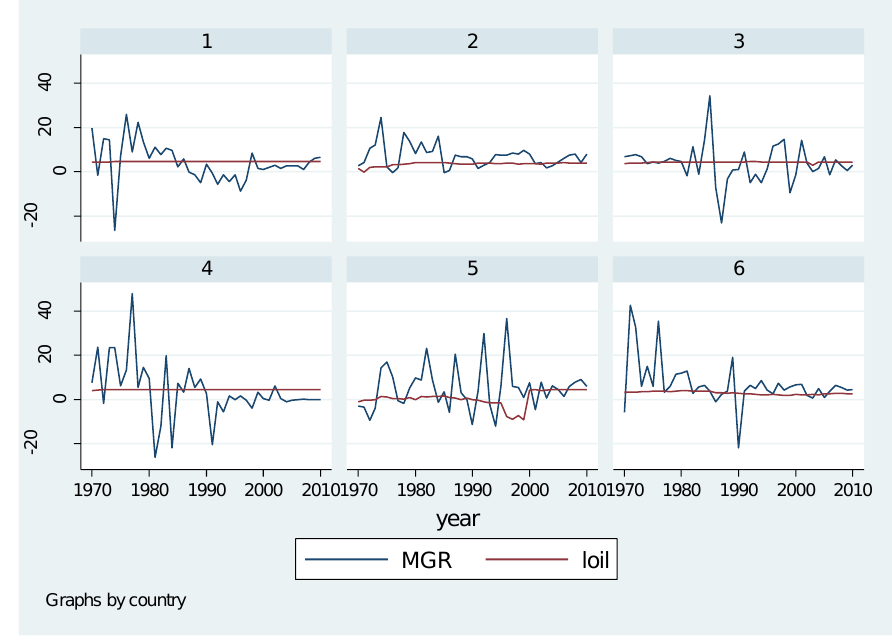
FIGURE 1: Manufacturing sector growth rate (mgr) and oil revenue (oil ) in AOECs Source: Authors’ calculations 1 = Algeria; 2 = Egypt; 3 = Gabon; 4 = Nigeria; 5 =